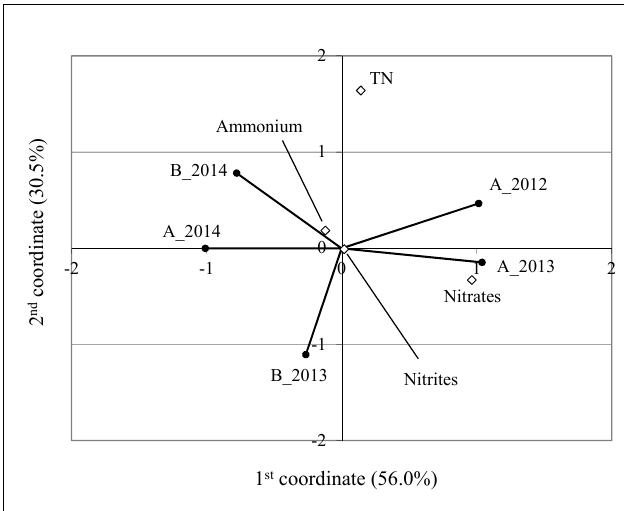
Figure 6. Position of experimental objects determined by different forms of nitrogen (ammonium, nitrates, nitrites and total nitrogen) in the space of the first two canonical variates and the spacing of these parameters in the dual space.